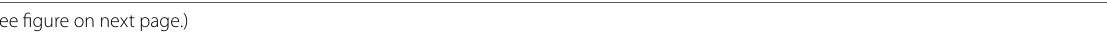
Fig. 6 Horizontal distribution of vertical velocity w at depths of a 100, b 200, and c 300 m. Vertical velocity was estimated by the P-vector inverse method from the AGEM-derived potential density field. Positive values show upward velocity. Contour intervals are 1 × 10 − 6 ms − 1 . Gray shadings indicate regions of no data because of small values of the Coriolis parameter and shallow water depth. Zonal and meridional thin solid lines denote locations of the w sections shown in Figs. 8a and 9a. Dotted square delineates the region where Nagano et al. (2016a) studied the QD variation in SST. In the solid square, vertical volume and temperature transports and SST tendency due to the vertical current variation were calculated as in